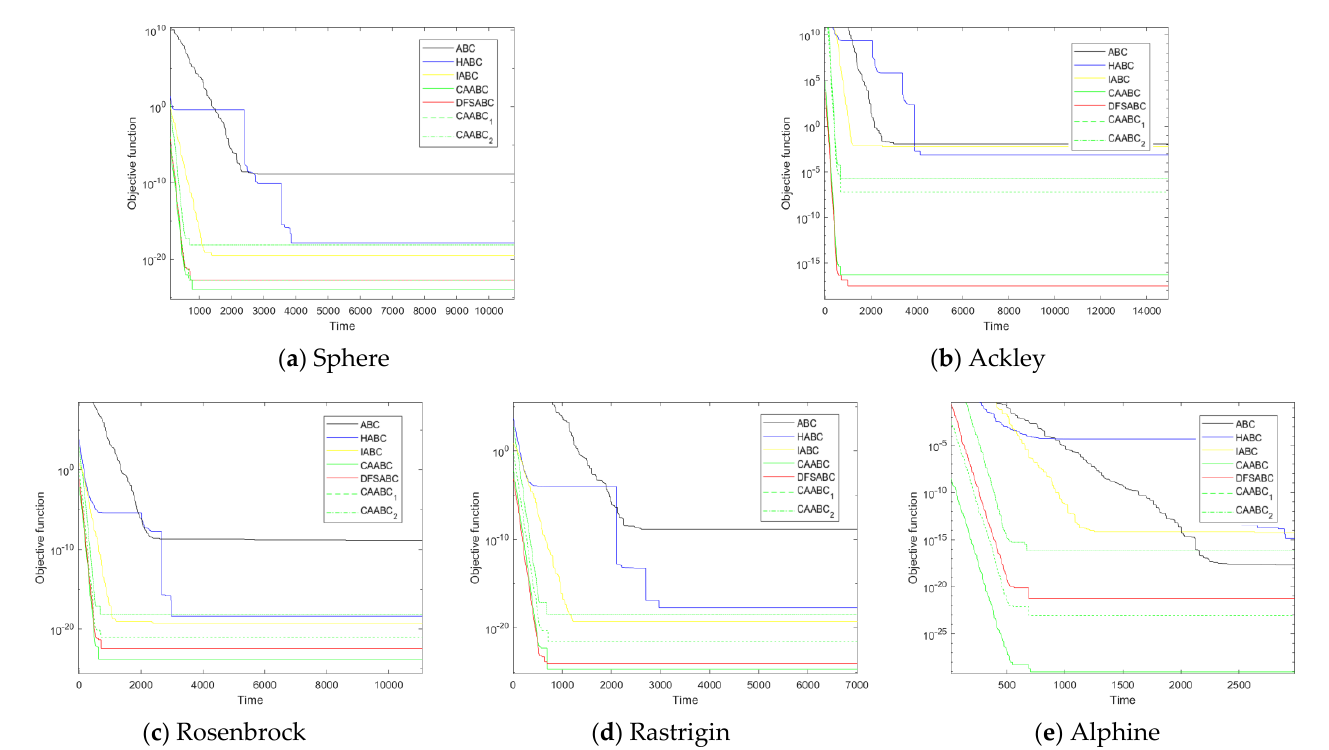
Figure 6. Comparison with other improved Artificial Bee Colony algorithms in 30 dimensions.